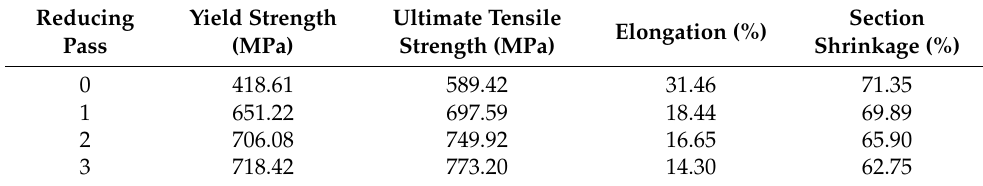
Table 4. Results of uniaxial te.sile